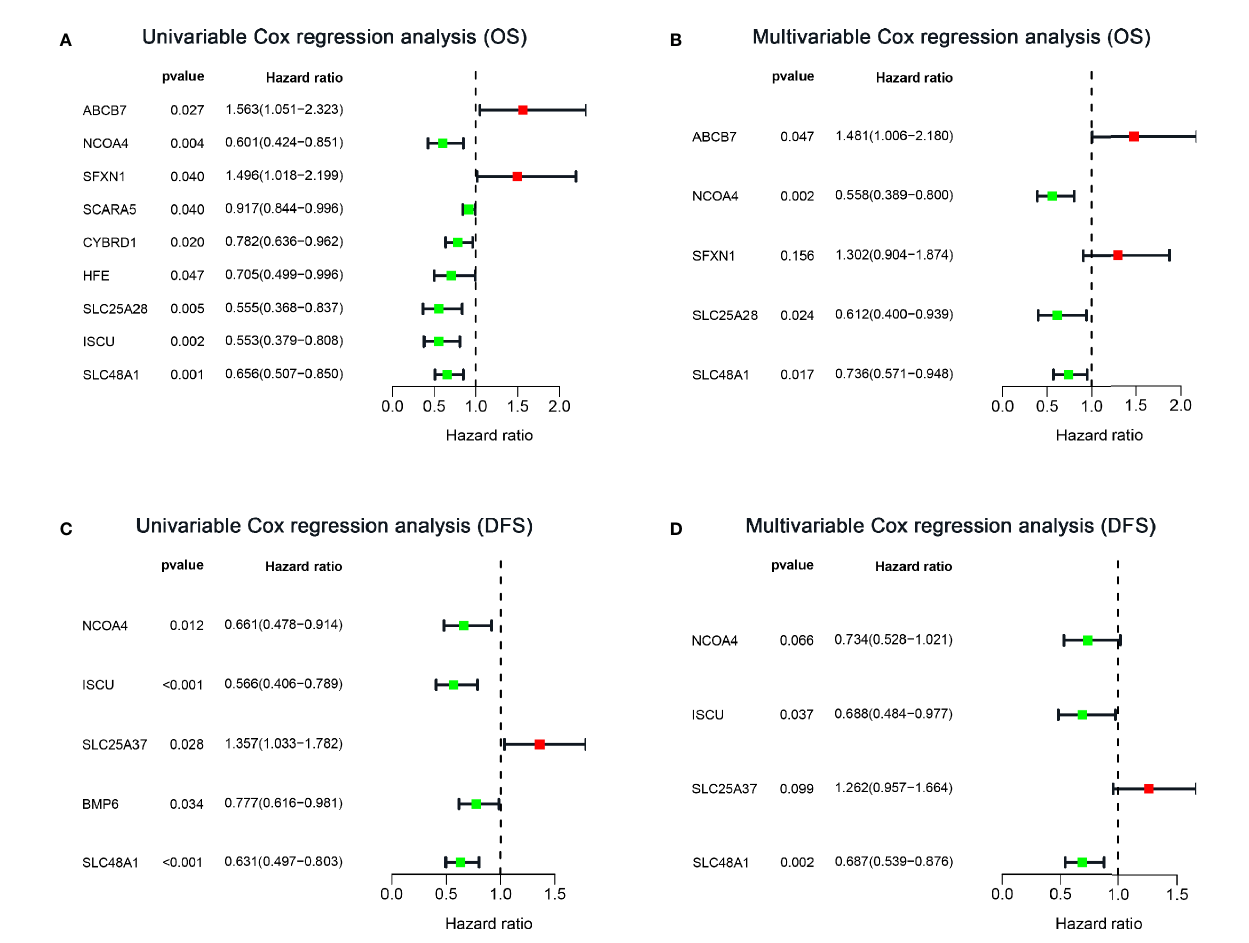
FIGURE 3 | Forest plots of IMRG hazard ratios of prognosis-associated IMRGs in sarcoma patients. (A, B) Univariate and multivariate Cox analysis results of OS- related IMRGs. (C, D) Univariate and multivariate Cox analysis results of DFS-related IMRGs. OS, Overall survival; DFS, disease-free survival; IMRGs, iron metabolism-related